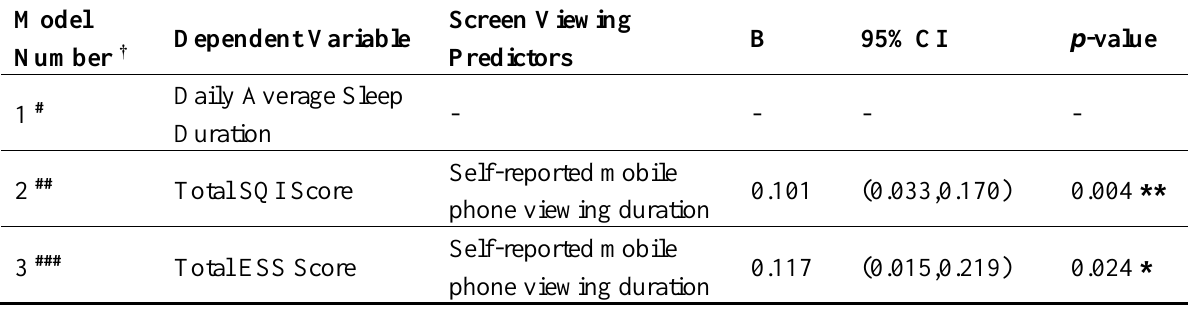
Table 5. Screen Viewing Predictors of Sleep